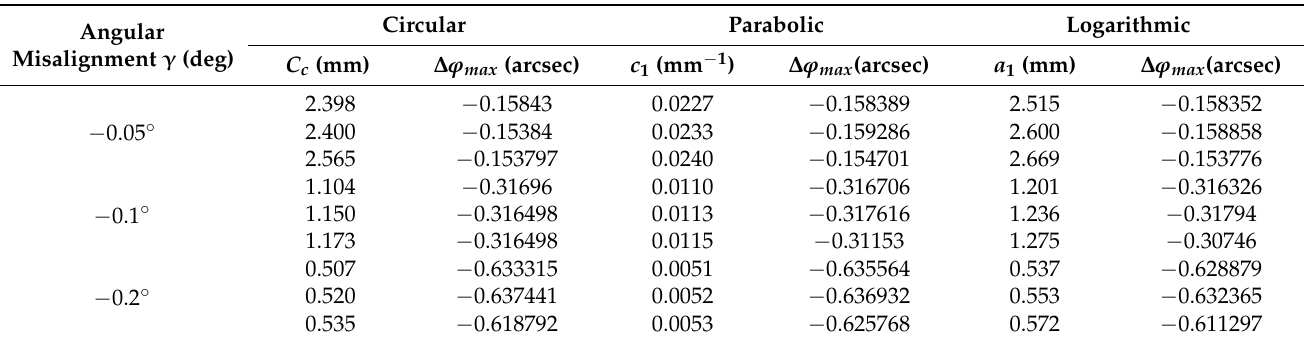
Table 5. Amount of modifications for different in-plane angular misalignment errors for helical gears meshing.